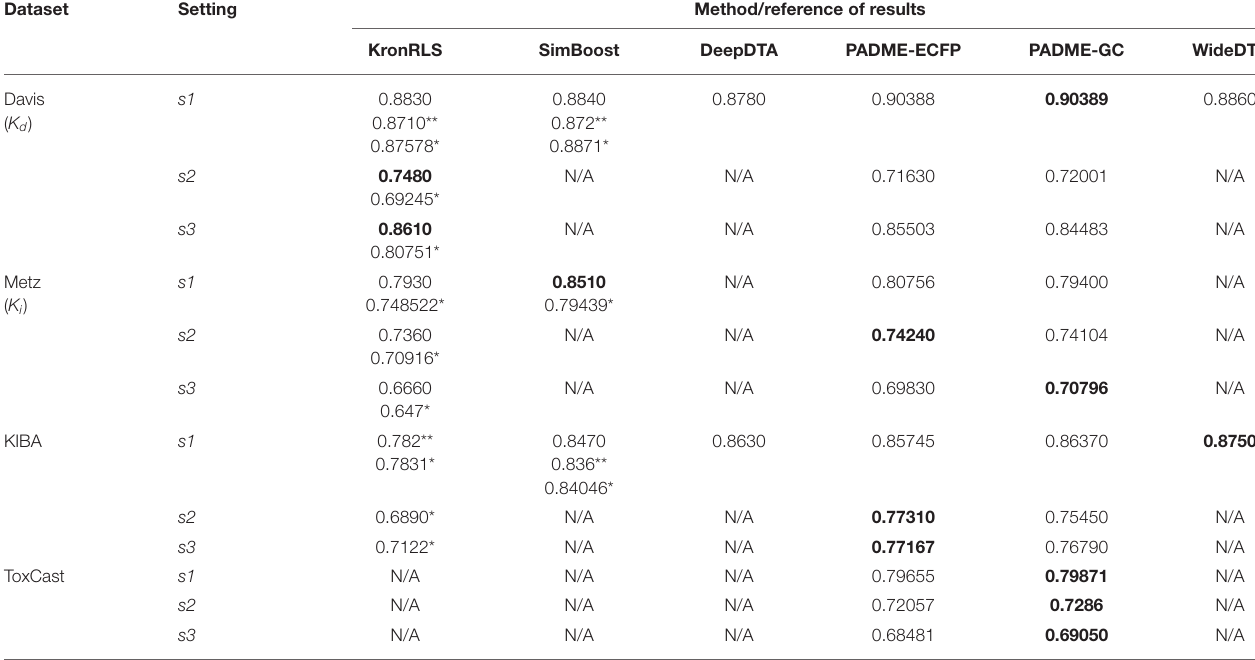
TABLE 3 | CI across multiple datasets of all baseline